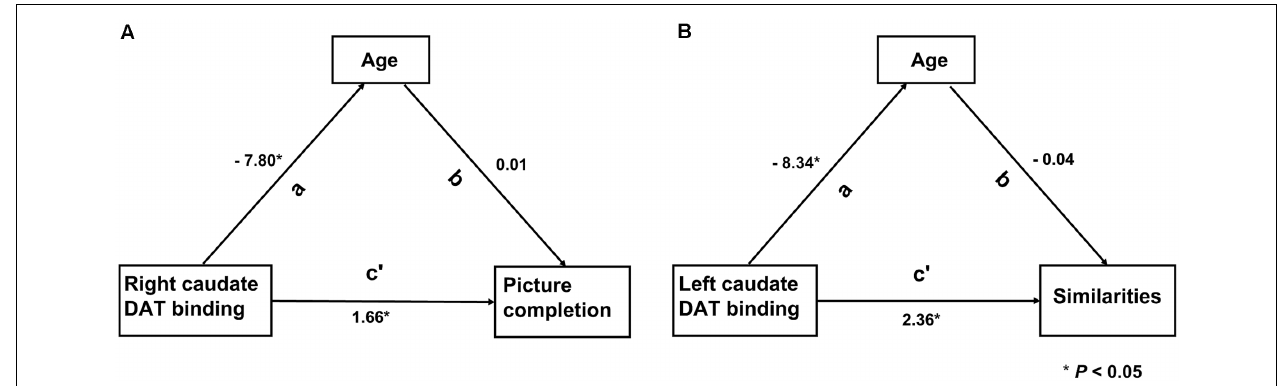
FIGURE 3 | The relationship among the striatal DAT binding, Wechsler Adult Intelligence Scale—third edition (WAIS-III) subscores and age. Two models remarked significantly by path analysis. (A) DAT binding value of right caudate was directly associated with the WAIS-III subscores of picture completion (c’). (B) Left caudate was directly associated with the WAIS-III subscores of similarities (c’). The indirect path was significant (a path) in both models. In this model, the direct and indirect relationships between aging, striatal DAT binding and cognition, the standardized path coefficients ( β ) are listed as a, b and c’, where a and b are part of the indirect path and c’ is the direct path adjusted for the indirect